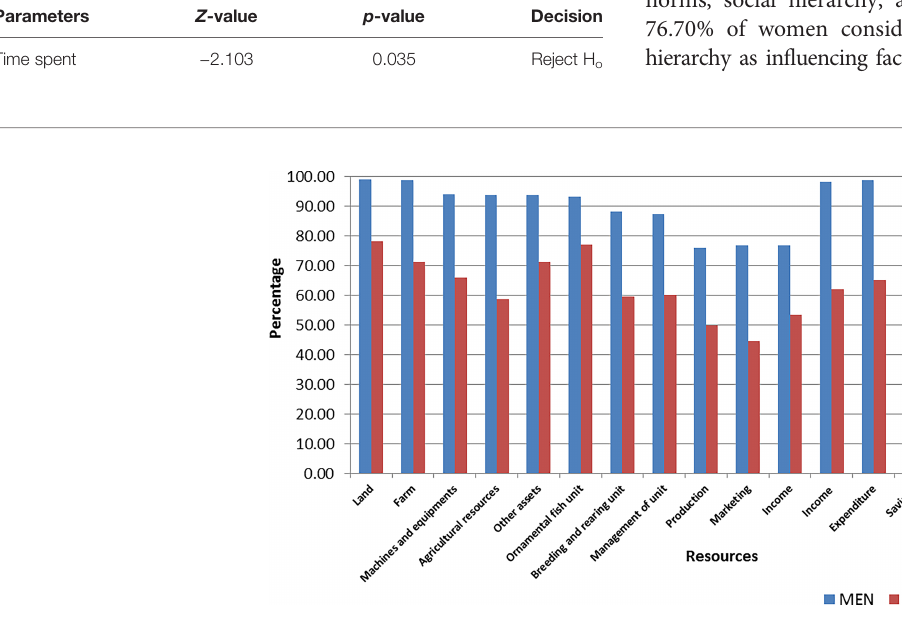
FIGURE 5 | Access over household, fi sheries, and fi nancial resources by men and